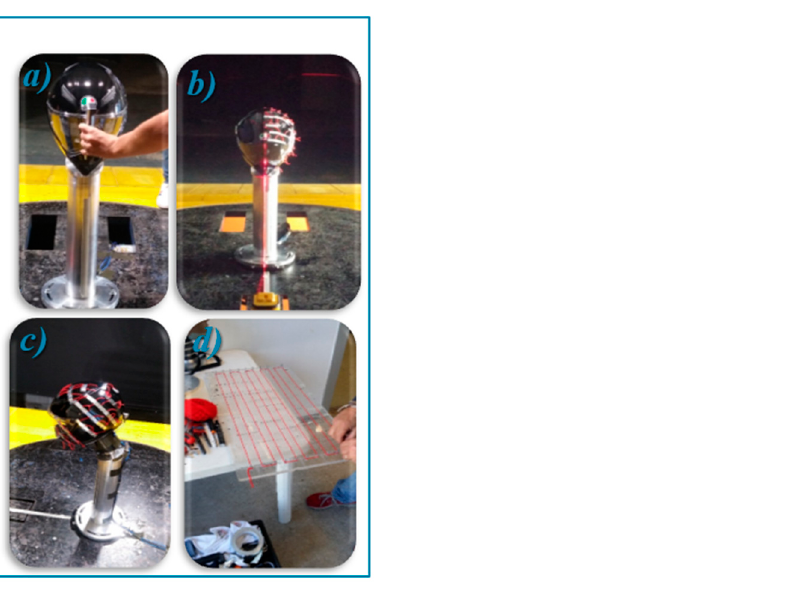
Figure 4. ( a ) Alignment with respect to the vertical axis; ( b ) centering; ( c , d ) application of wool threads.